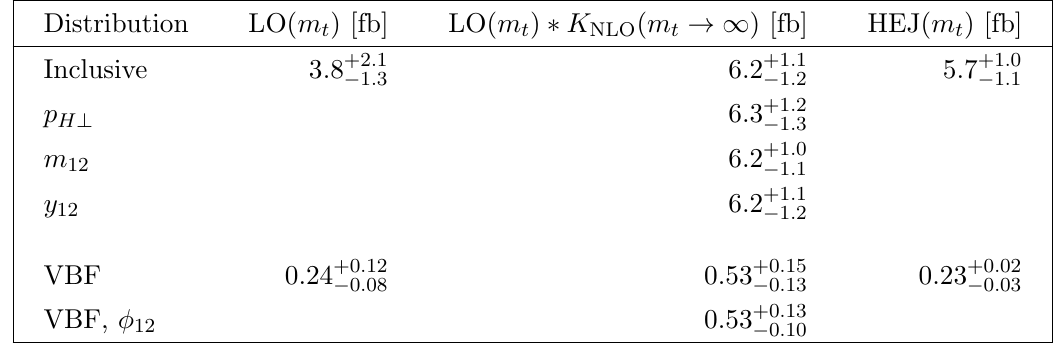
Table 1 . Cross sections obtained at LO, LO scaled with bin-by-bin K -factor for various distribu- tions, and the HEJ with the inclusive cross sections scaled to